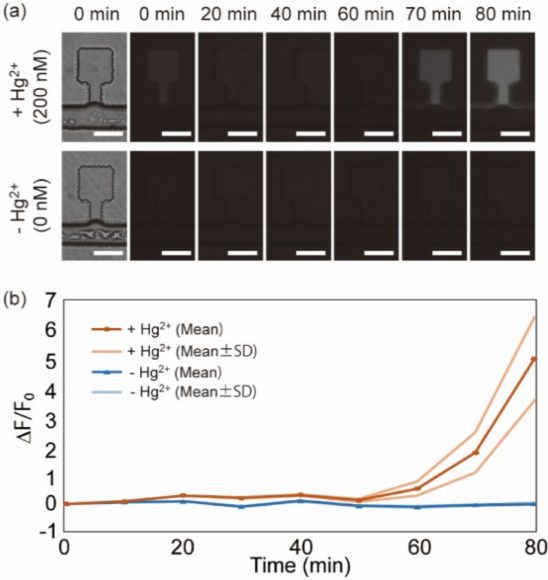
Figure 6. Detection of mercury ions in the water sample. ( a ) Microscopic images of the representative microchambers with 200 nM of Hg 2+ (upper row) and 0 nM of Hg 2+ (lower row). Bright-field images at the initial state (left end) and time-lapse fluorescence images from 0 to 80 min. The exposure time was 5 s. The time interval between acquiring images was 10 min. The scale bars are 100 µ m. ( b ) Time- course of the average relative fluorescence intensities in the microchambers with water containing 200 nM of Hg 2+ (+Hg 2+ ) or 0 nM of Hg 2+ ( − Hg 2+ ). 200 ng/ µ L of pHg-deGFP was contained in the CFPS solution when freeze-drying. Curves with the dark colors represent average values (Mean). Curves with the light colors represent average ± standard deviation ( n = 4) (Mean ± SD). The freeze-drying condition of the microfluidic device was ~10 mTorr, − 20 ◦ C, 3